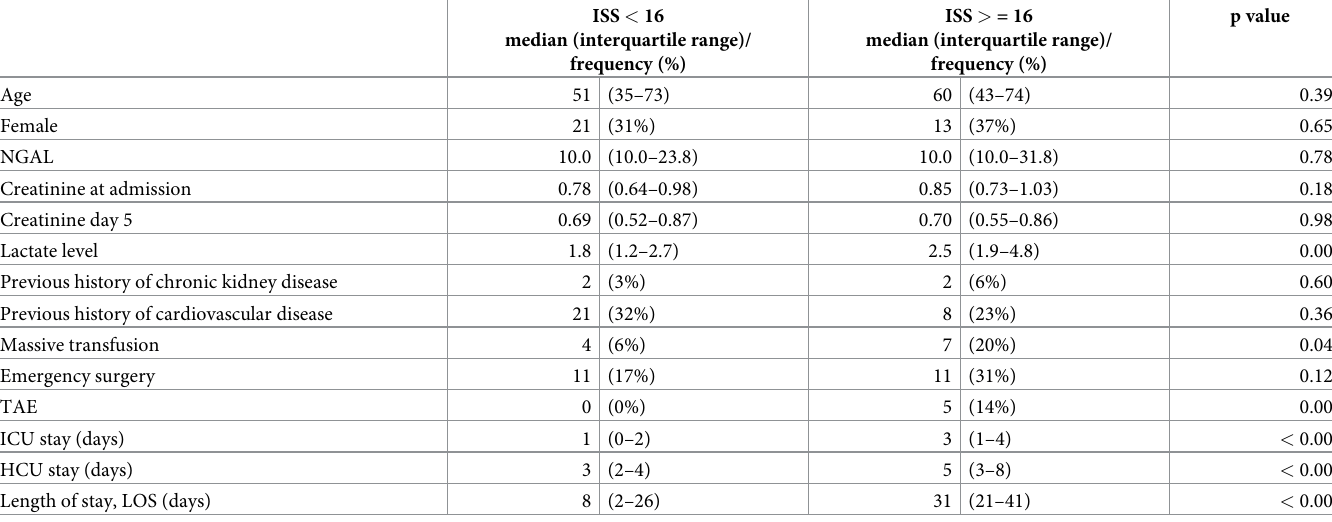
Table 1. Outcomes and patient characteristics based on trauma severity.